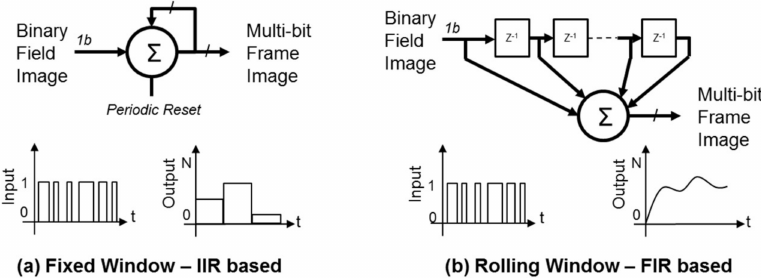
Figure 5. The two primary methods of temporally summing single photon bit planes: ( a ) Fixed averaging based on an IIR filter with periodic reset (i.e., a simple counter). ( b ) Rolling averaging based on FIR